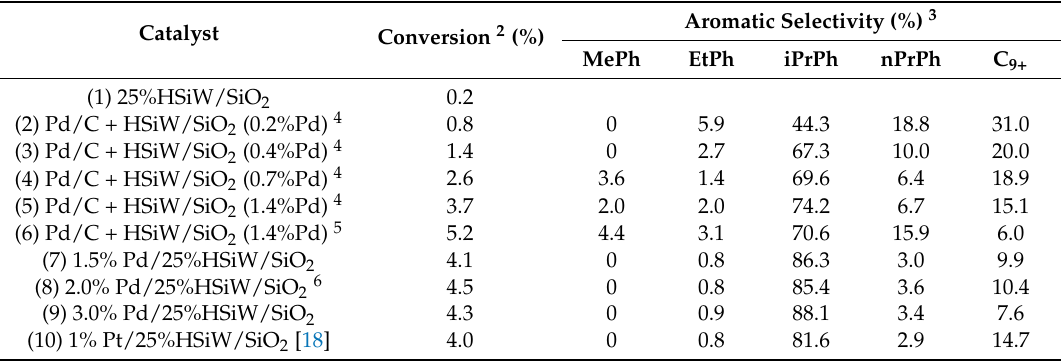
Figure 2. Time course for benzene alkylation by propane over 2% Pd/HZSM-5 (Si/Al = 10) (0.20 g catalyst, 1 bar pressure, inlet molar ratio C 6 H 6 /C 3 H 8 = 1:9, 10 mL min − 1 flow rate, W / F = 80 g h mol − 1 ; catalyst pre-treatment at 300 ◦ C/1 h in H 2 flow). Table 2. Alkylation of benzene with propane over Pd-HSiW catalysts.